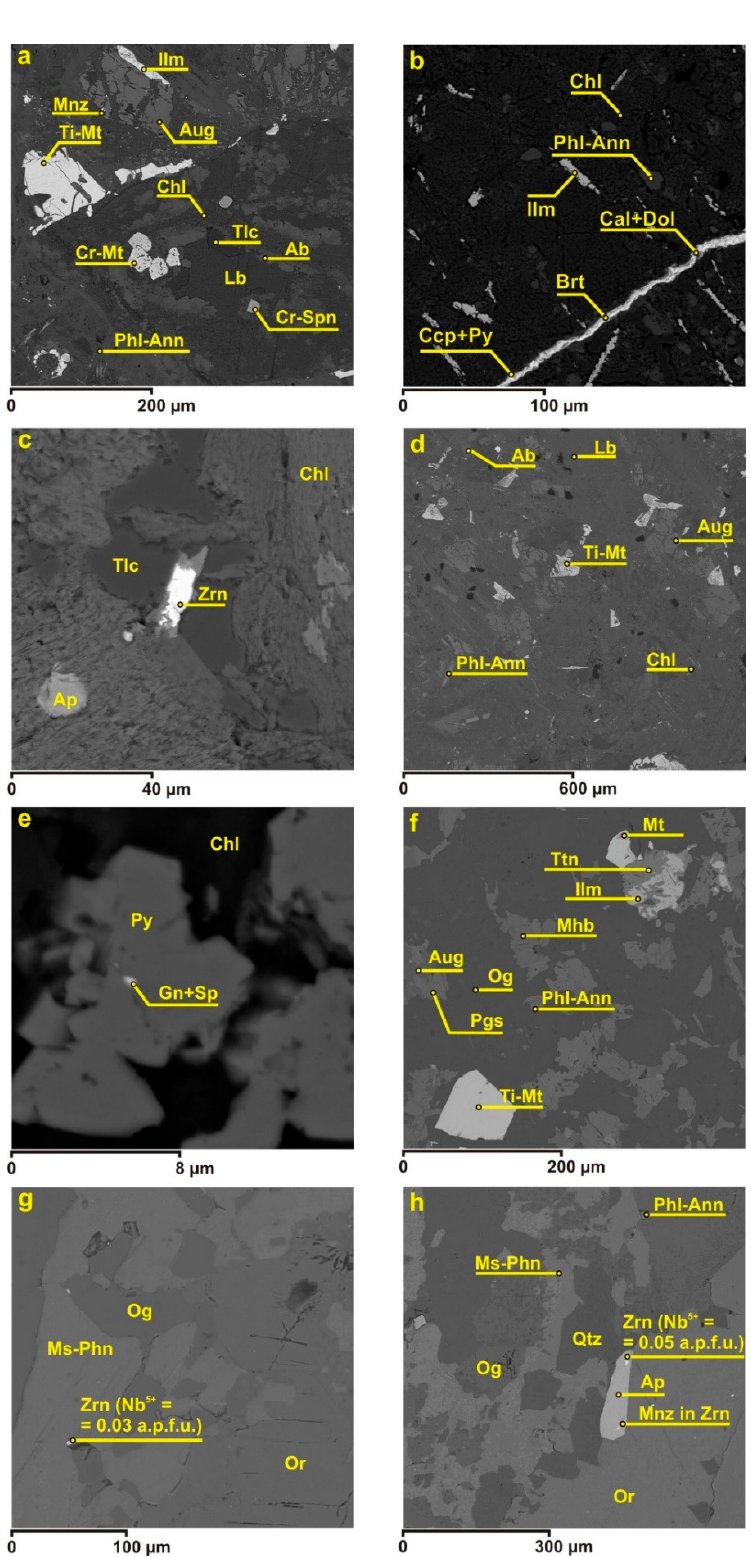
Figure 4. Back-scattered electron images of minerals from the dike rocks: ( a–c )—picrodolerites (sample YR16-4), ( d )—dolerite (sample A09-15), ( e )—dolerite (sample A09-15-1), ( f )—quartz diorite (sample A09-11), ( g,h )—leucocratic granites (sample M08-03). Mineral names abbreviations—from [37].